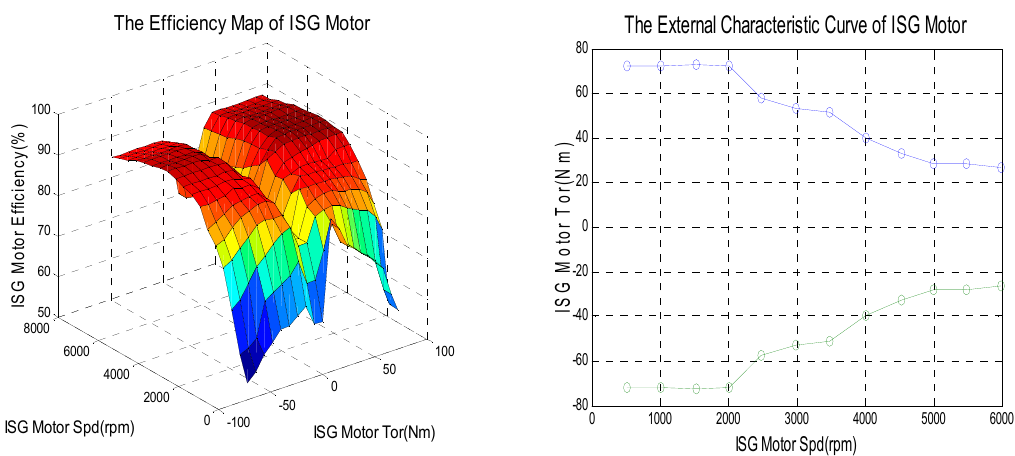
Figure 3. Working efficiency curve and external characteristic curve of integrated starter generator (ISG) motor.